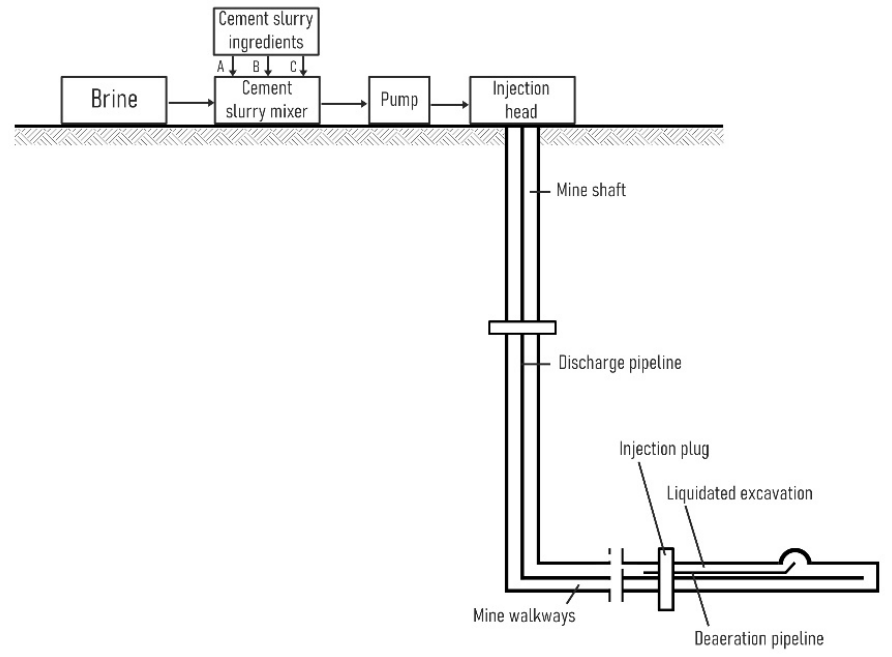
Figure 3. Scheme of pipeline injection